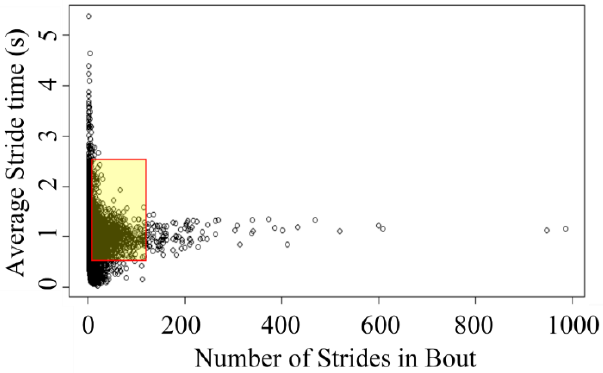
Figure 3. Mean stride time for walking bouts of length 1–1000 for a Parkinson’s disease participant, indicating dependence of stride time on the duration of walking bout. Shaded area indicates included bouts.